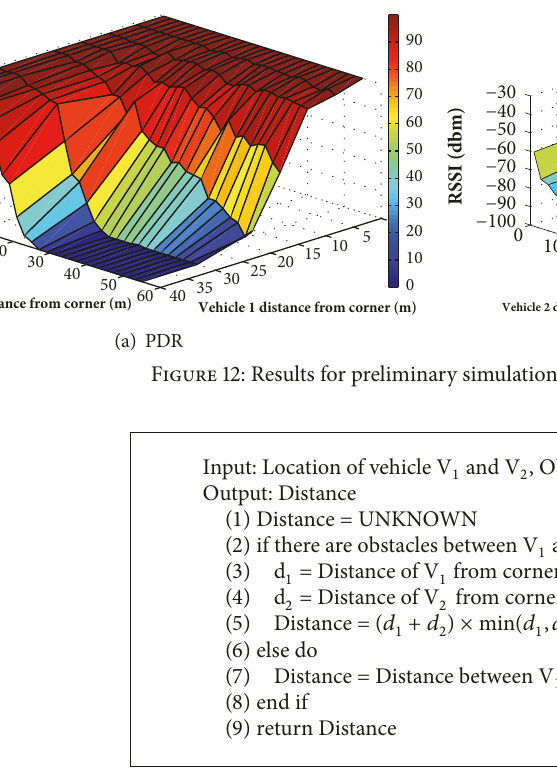
Algorithm 1: Blind corner